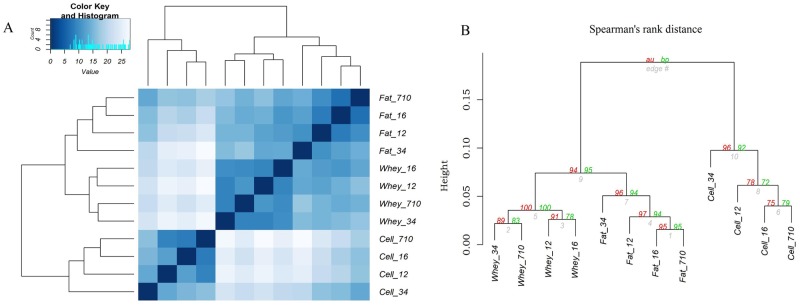
Clustering of milk samples using Hierarchical clustering (Spearman’s rank correlation) (6A) and Pvclust with bootstrap analysis (1000 times) (6B).Normal bootstrap resampling values are represented in the Fig by green letters "bp", for "bootstrap probability". The multi-scale bootstrap resampling probabilities are represented by red letters "au", for "approximately unbiased", and are generally preferred over the "bp" bootstrap probabilities.